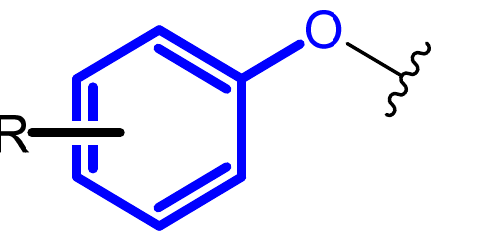
Figure 1. Unsubstituted terminal phenoxy group or substituted with R substituent.